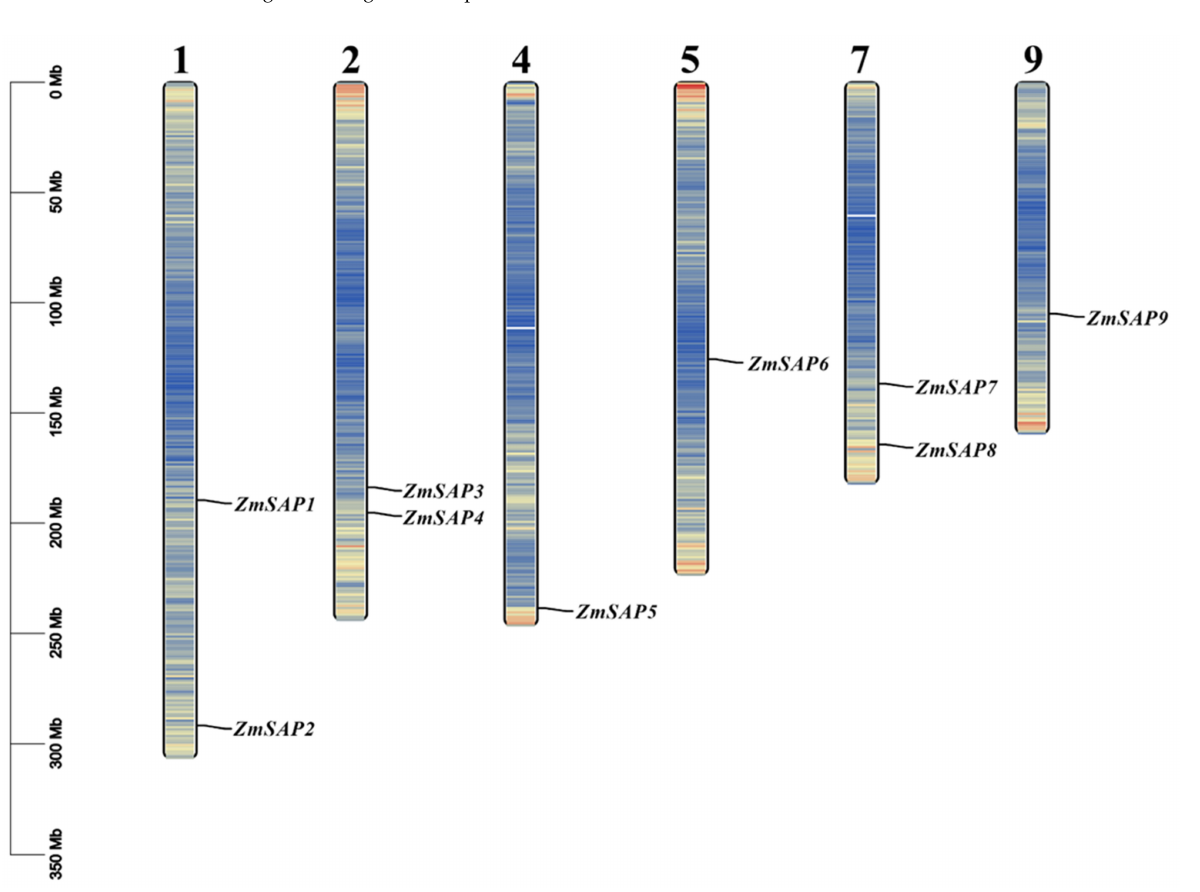
Figure 1. The number and location of SAP genes on maize chromosome, and the gene density on each chromosome, the number of genes from blue to red. Gene density was generated by TBtools. The parameter of bin size was set to 10 5